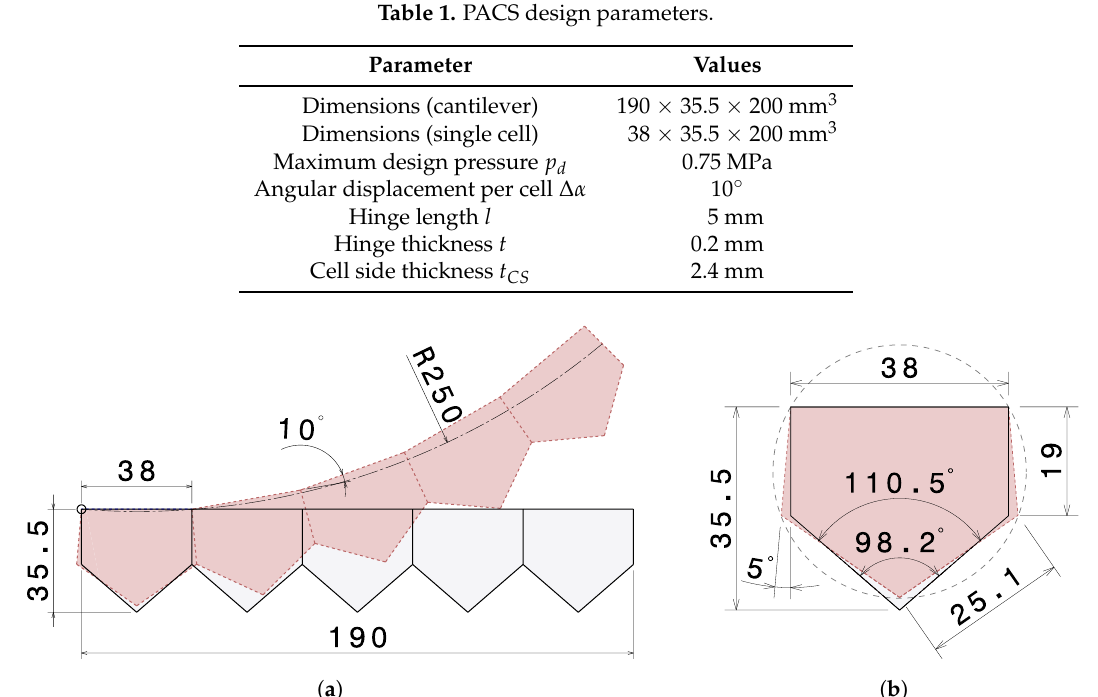
Figure 8. PACS design parameters: ( a ) Five-cell PACS cantilever geometry. ( b ) PACS unit cell.